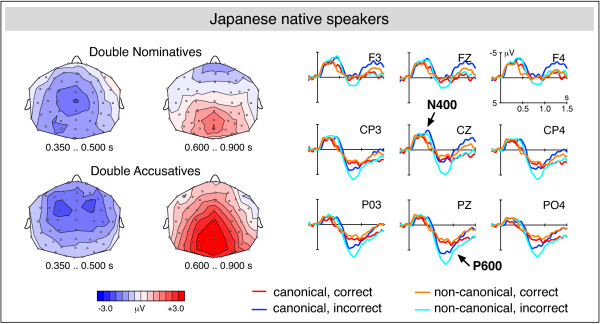
ERPs time-locked to the onset of the second noun for Japanese native speakers (red line: correctly case marked nouns in canonical sentences; orange line: correctly case marked noun in non-canonical sentences; dark blue line: double nominatives (canonical sentences); light blue line: double accusatives (non-canonical sentences). The topographical isovoltage maps represent difference potentials of the case violation minus the correct condition of the same sentence type.